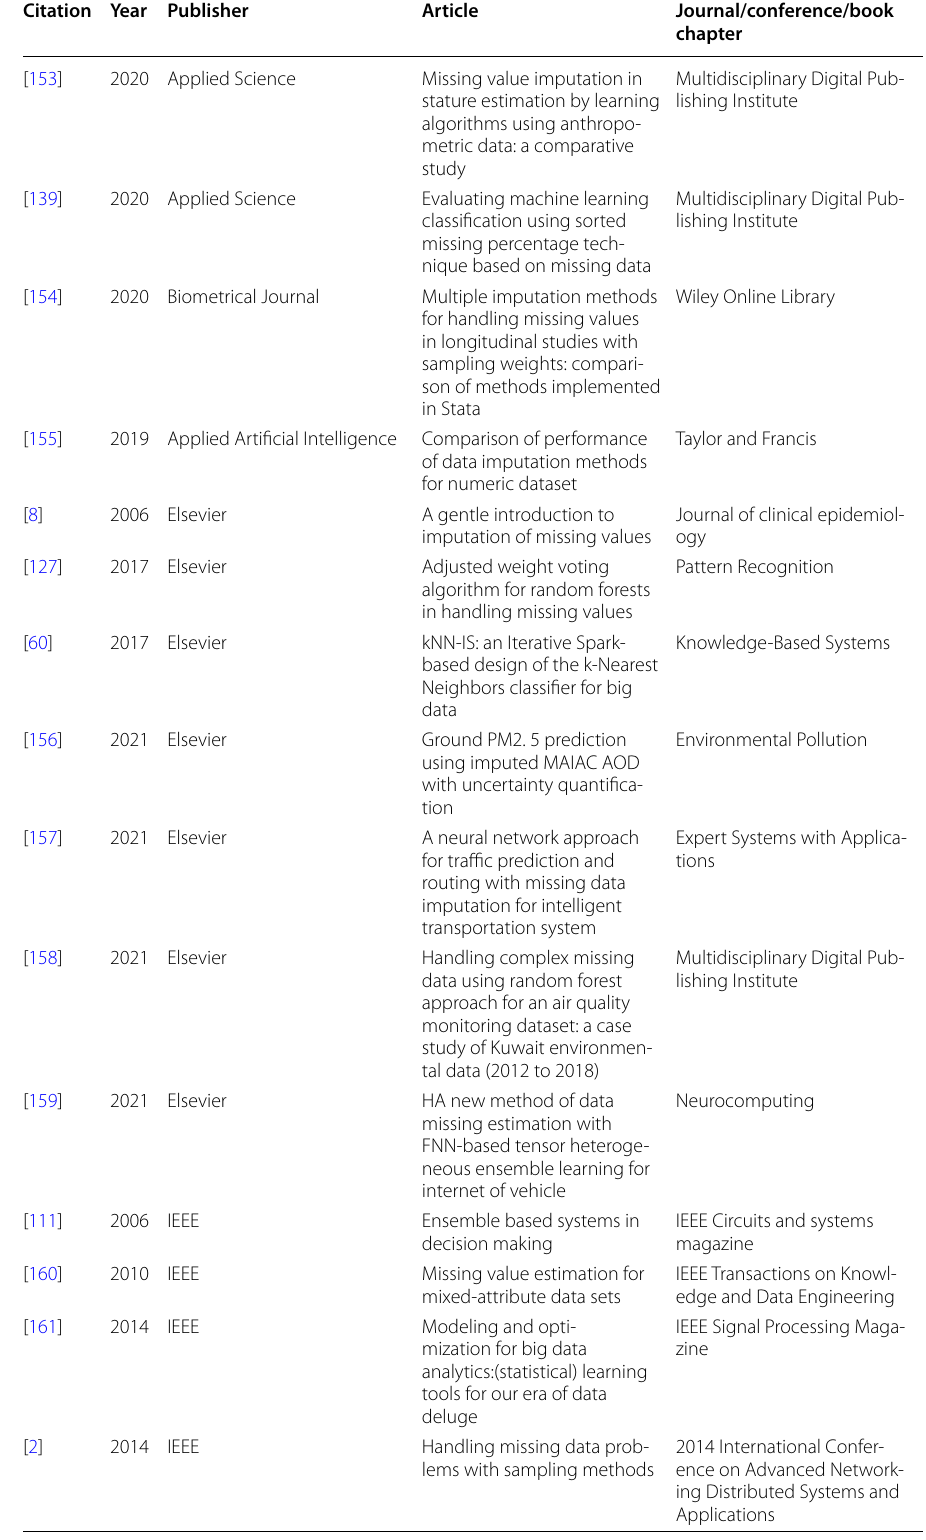
Table 2 Details of selected articles for missing values